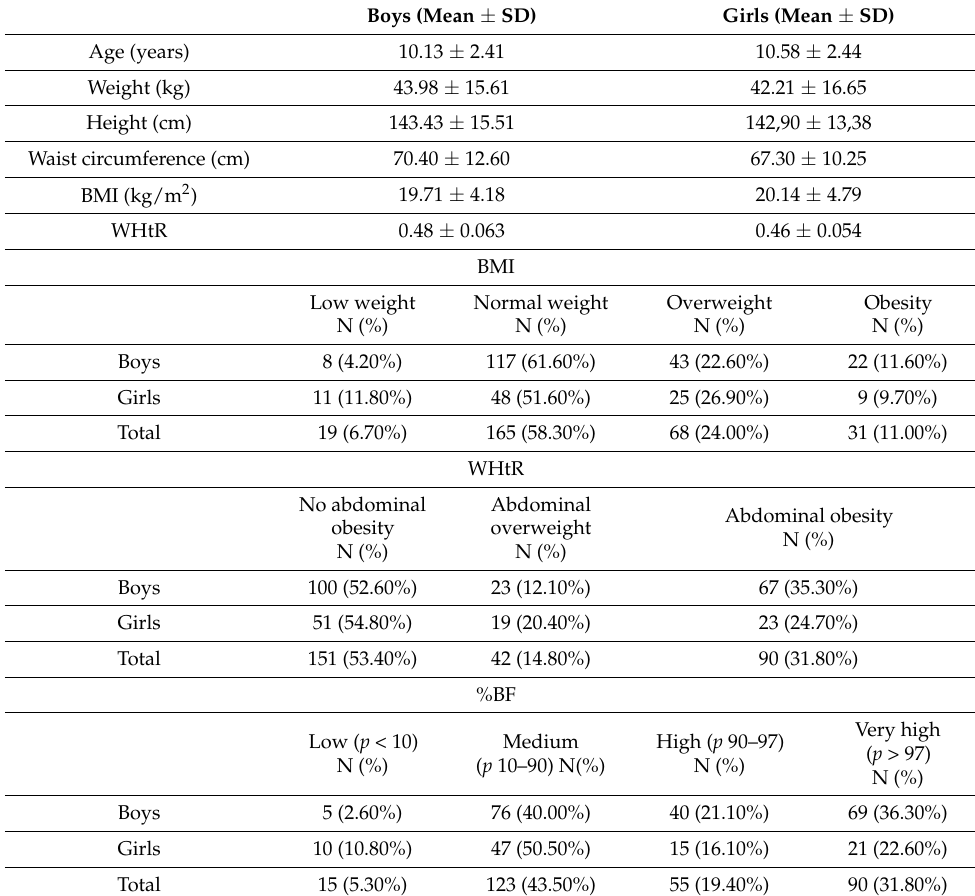
Table A3. Anthropometric profile of the sample stratified by sexes and classified by nutritional condition by Body Mass Index (BMI), Waist-to-height Ratio (WHtR), and Percent Body Fat